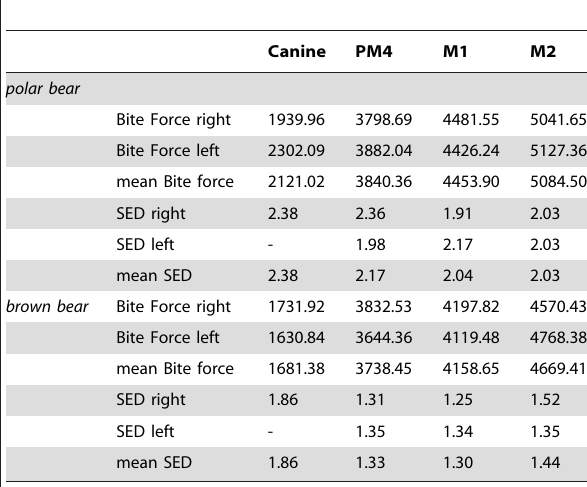
Table 2. Bite forces and strain energy density (SED) values for the two models under four simulated